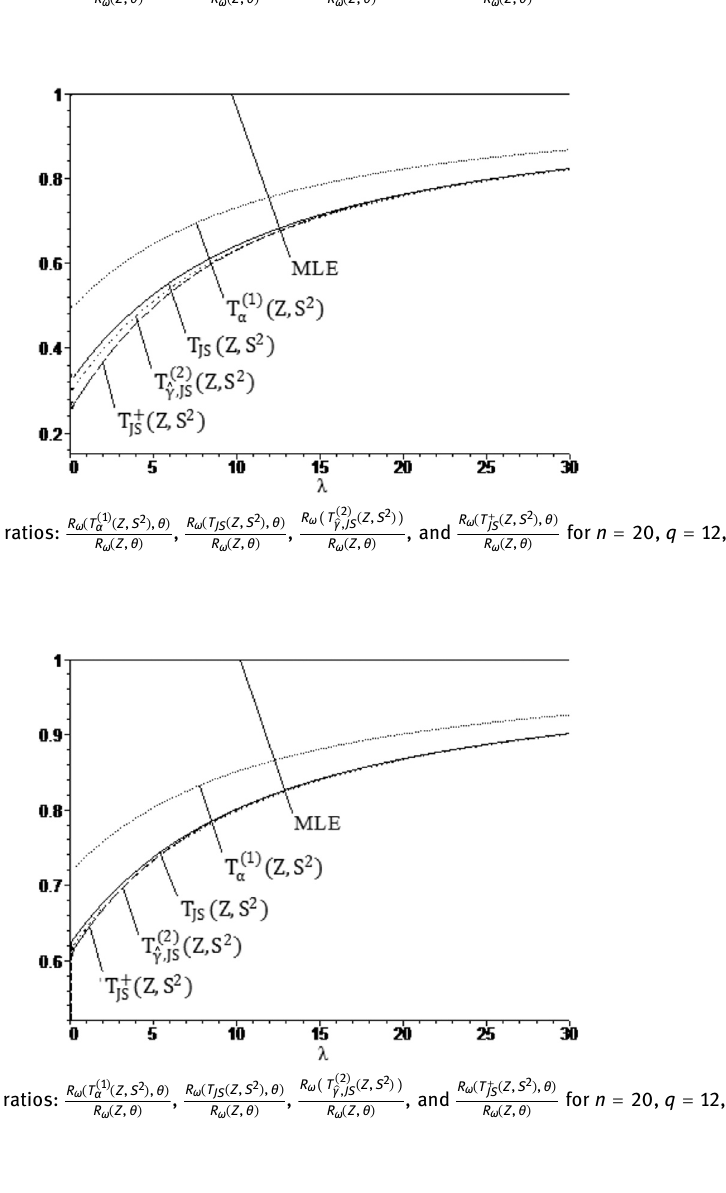
Figure 3: Curves of the risk ratios: R T Z S θ